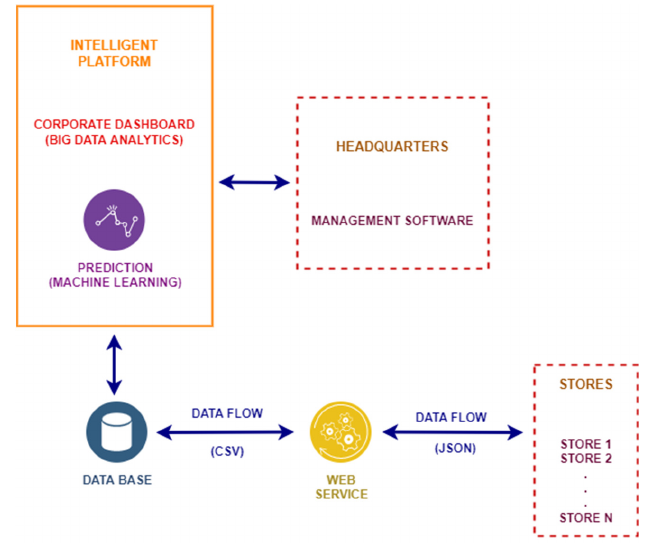
Figure 1. Functional scheme of the proposed intelligent system.